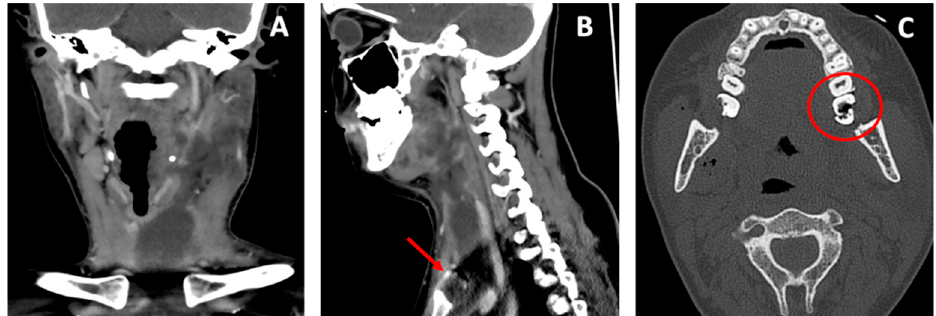
Figure 1. Computed tomography scan of the abscess affecting the deep space of the neck and the anterior mediastinum in coronal view ( A ). The red arrow in sagittal view shows the abscess behind the sternal manubrium ( B ). In the axial view the red circle shows the broken third inferior left molar ( C ).